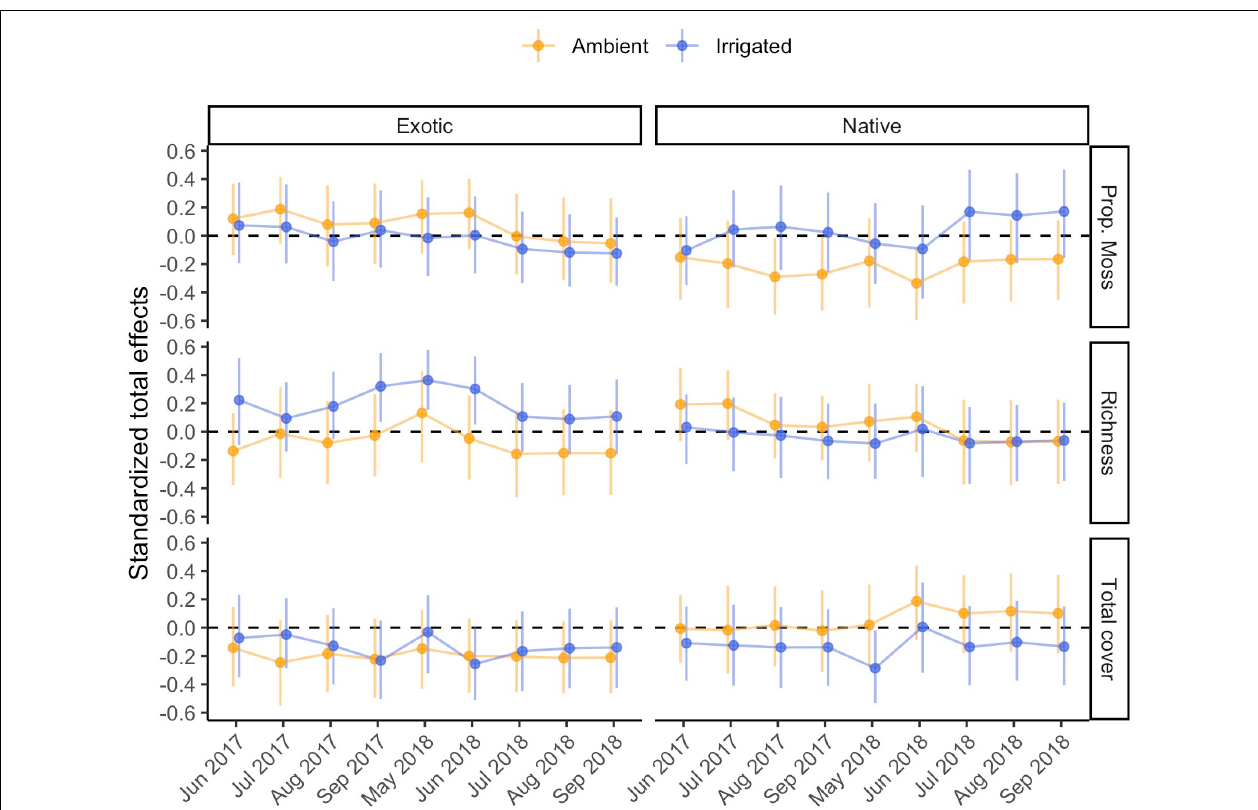
FIGURE 4 | Standardized total effects of biocrust properties on exotic and native plant cover through time, under ambient and irrigated conditions. Error bars represent 95% bootstrap confidence intervals based on 5,000 bootstrap samples. Because total effects of composite variables cannot be computed, the effect of biocrust condition is